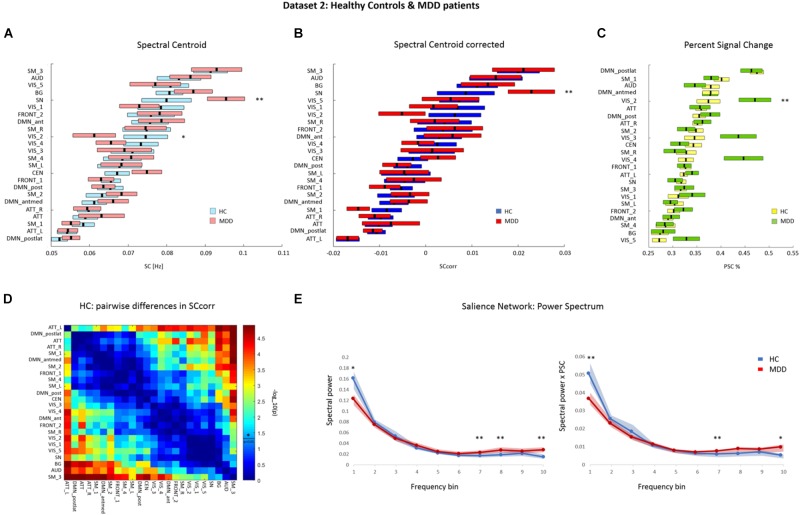
Dataset 2: (A) Mean ± SEM SC values of each RSN in HCs and MDD patients. RSNs are ordered according to increasing SC magnitude in HC. SCs were calculated based on the power spectra of BOLD network fluctuations within the frequency range of 0.01–0.25 Hz. (B) Mean ± SEM SC values corrected for percent signal change (PSC) in HC and MDD, ordered according to increasing corrected SC magnitude in HC. (C) Mean ± SEM PSC values of each RSN in HC and MDD patients. RSNs are ordered according to increasing PSC magnitude in HC. Ordering on the y-axis differs between plots. (D) Matrix representing p-values of pairwise differences in the corrected SC between individual RSNs in HC. The colors indicate the significance, where red stands for lower p-value and higher significance, and blue for higher p-value thus lower significance. P-values were scaled with a –log10(p) transform, the colorbar value of 1.3 corresponds to p = 0.05 (as indicated by a vertical line across the colorbar and an asterisk which represent significance threshold). (E) Mean and SEM spectral power of SN at 10 frequency bins in HC (blue) and MDD patients (red). Left panel represents the original power spectrum. Right panel represents the power spectrum rescaled by PSC, where spectral power values for each frequency bin and each subject were multiplied by the corresponding PSC value of SN BOLD fluctuations. (∗∗) and (∗) indicate significant difference and a tendency toward significance, respectively, in a given measure between groups–tested with corresponding statistic. ATT, attention; AUD, auditory; BG, basal ganglia; CEN, central executive network; DMN, default-mode network; FRONT, frontal; SM, sensorimotor; SN, salience network; VIS, visual; L, left; R, right; ant, anterior; antmed, anterior-medial; post, posterior; postlat, posterior-lateral.